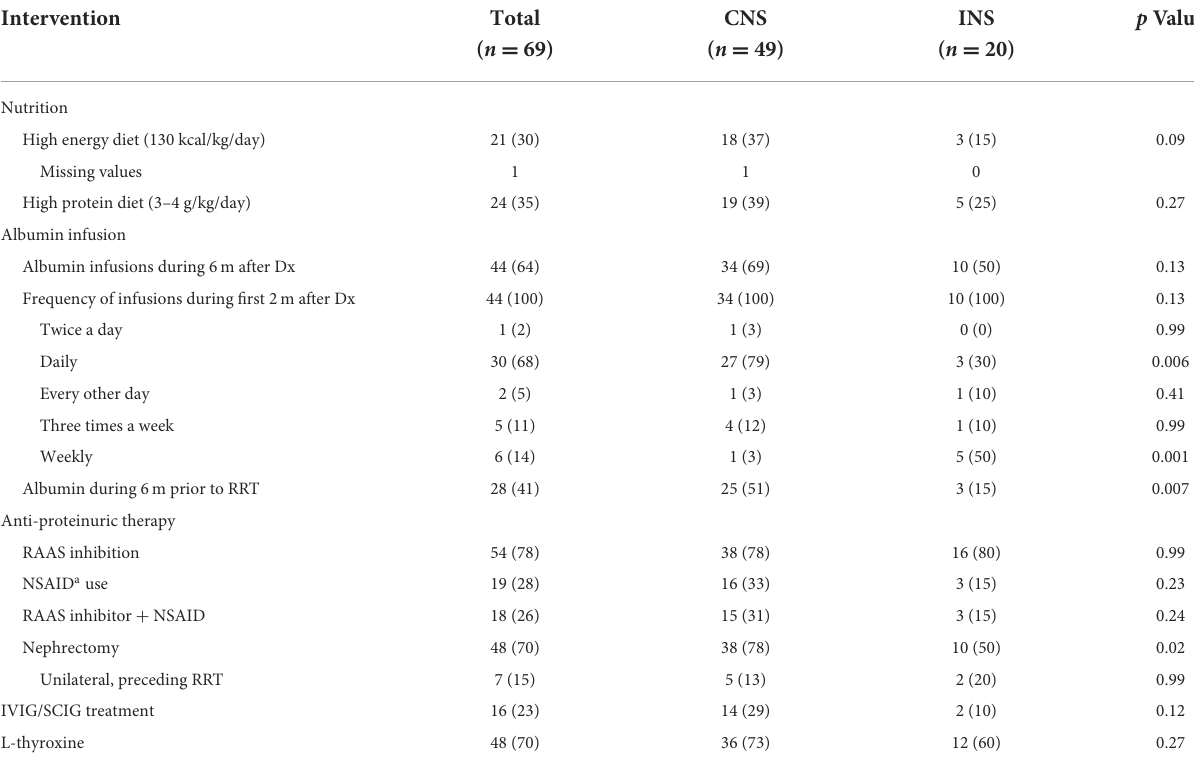
TABLE 2 Interventions in children with CNS and